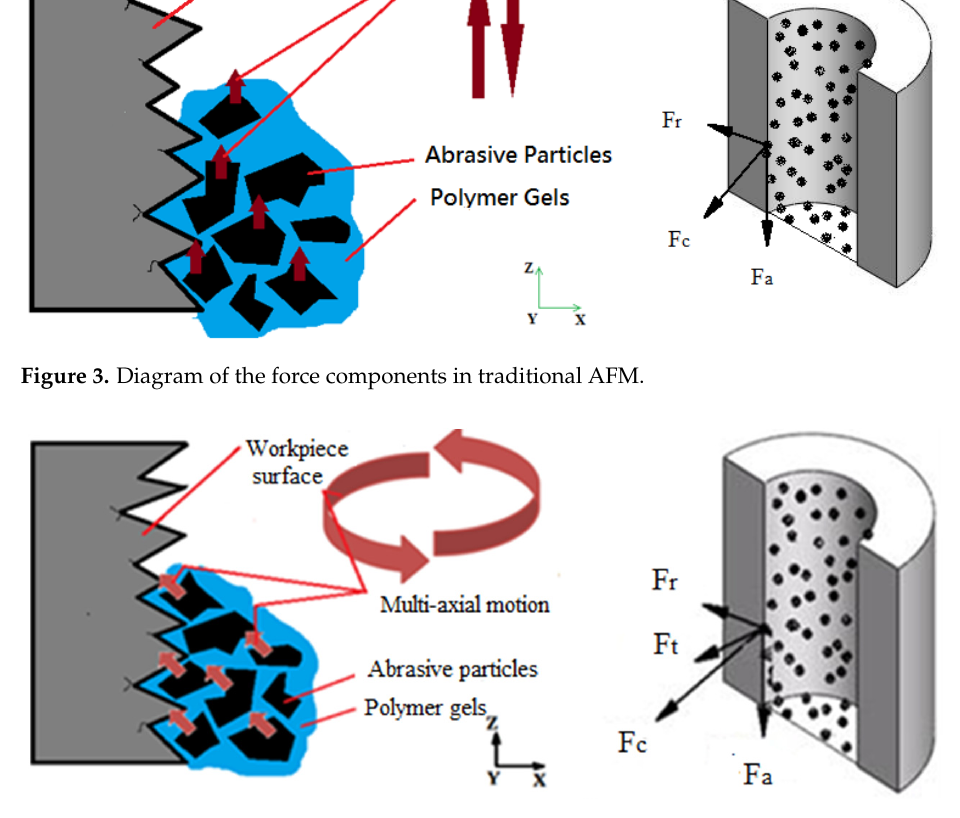
Figure 4. Additional tangential forces (Ft) were created by the rotational gel abrasive.